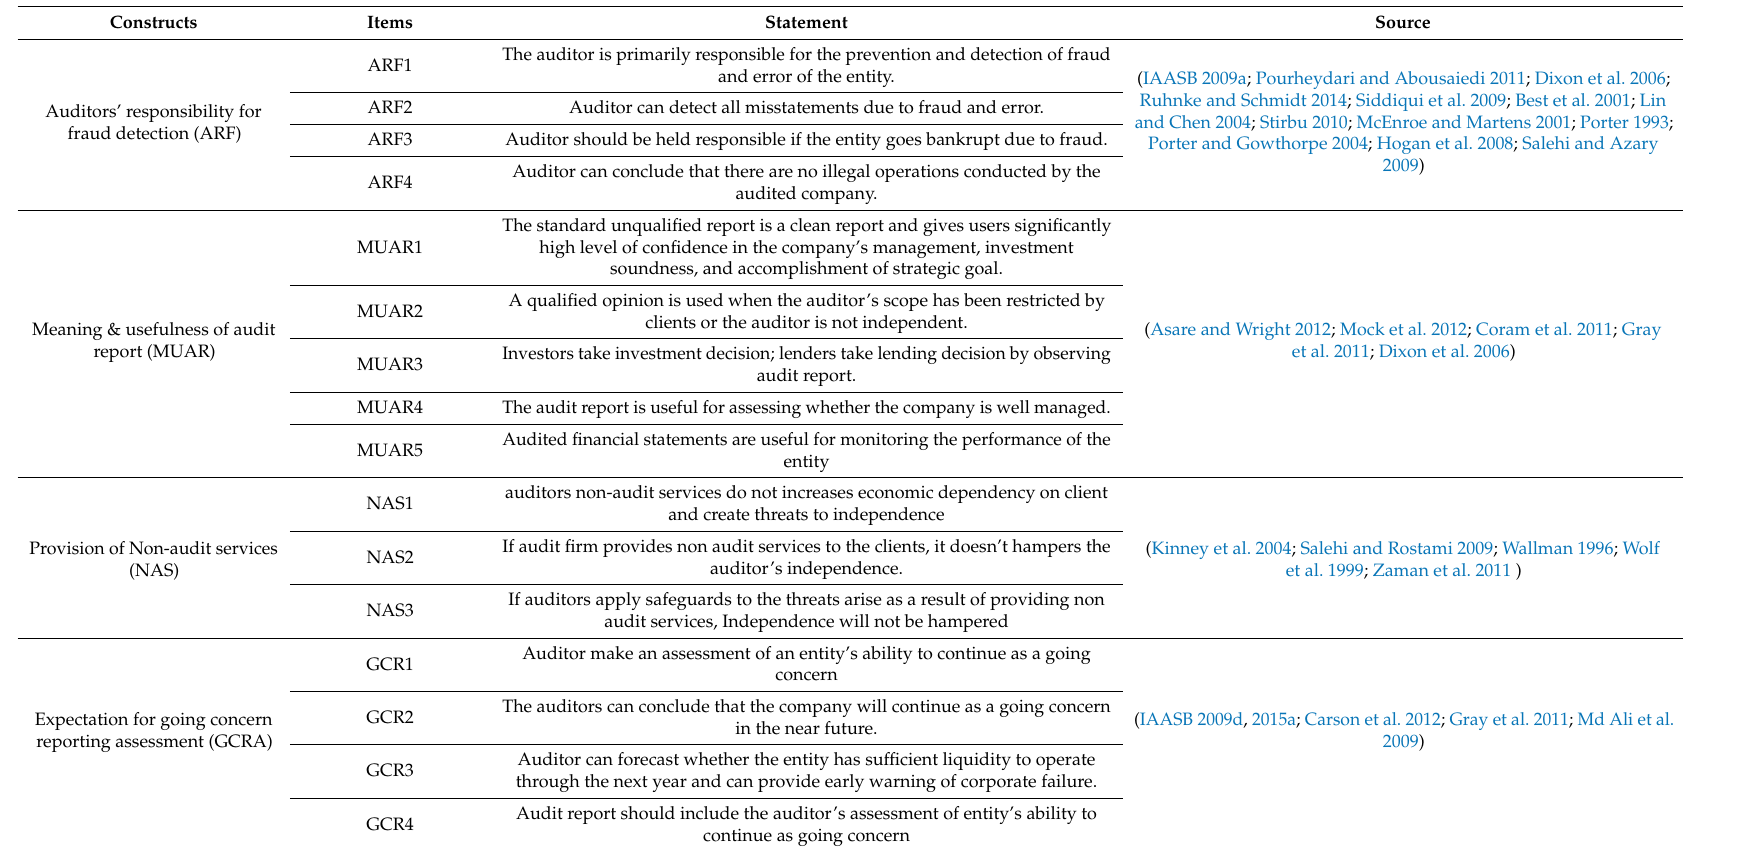
Table A1. List of